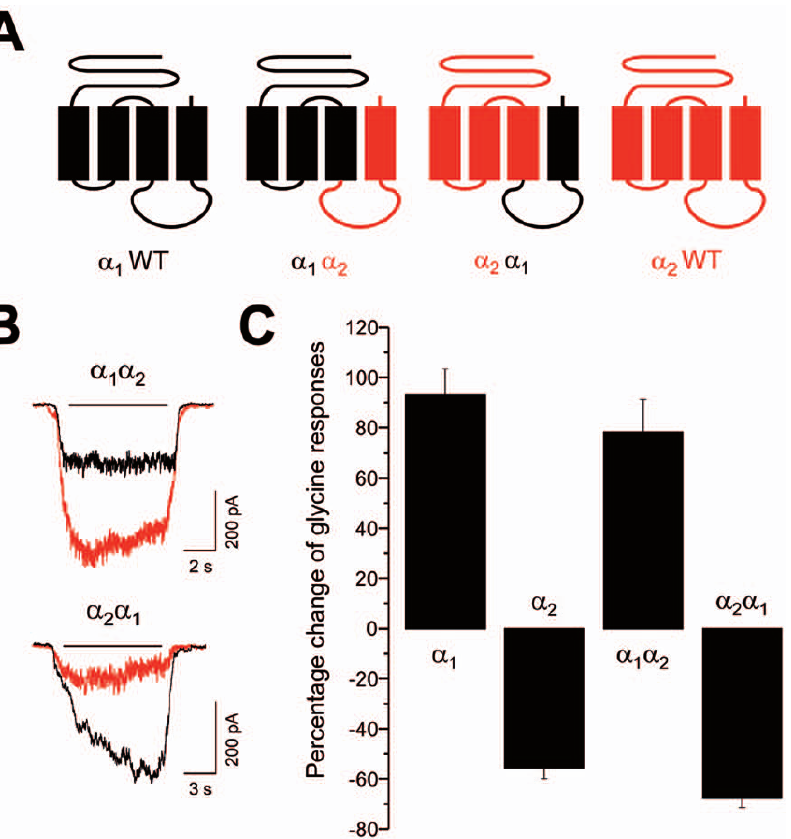
Figure 2. NA-Gly effects on chimeric GlyR constructs. ( A ) Schematic depiction of wild type and chimeric GlyRs. ( B ) Examples of whole-cell currents recorded from a 1 a 2 or a 2 a 1 GlyRs before (black) and during the application of NA-Gly (10 m M, red). ( C ) Percent change of the normalized glycinergic membrane currents during the application of NA-Gly (10 m M) using equipotent (EC 10 ) glycine concentrations. The exchange of the IL between TM3 and TM4 plus the TM4 domain between a 1 and a 2 GlyRs did not significantly influence the NA-Gly-induced